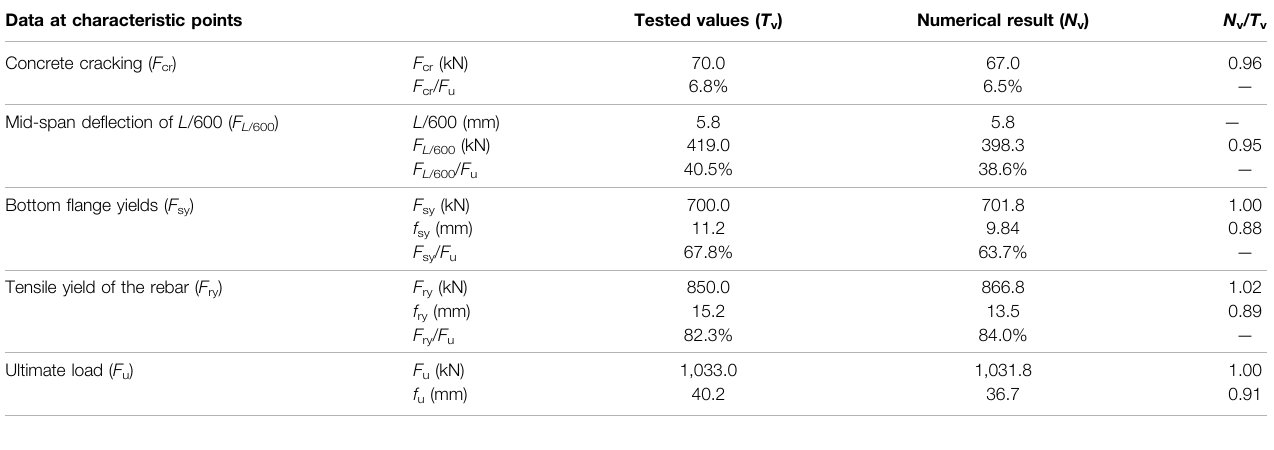
TABLE 2 | Comparison of calculated and tested values at characteristic points.